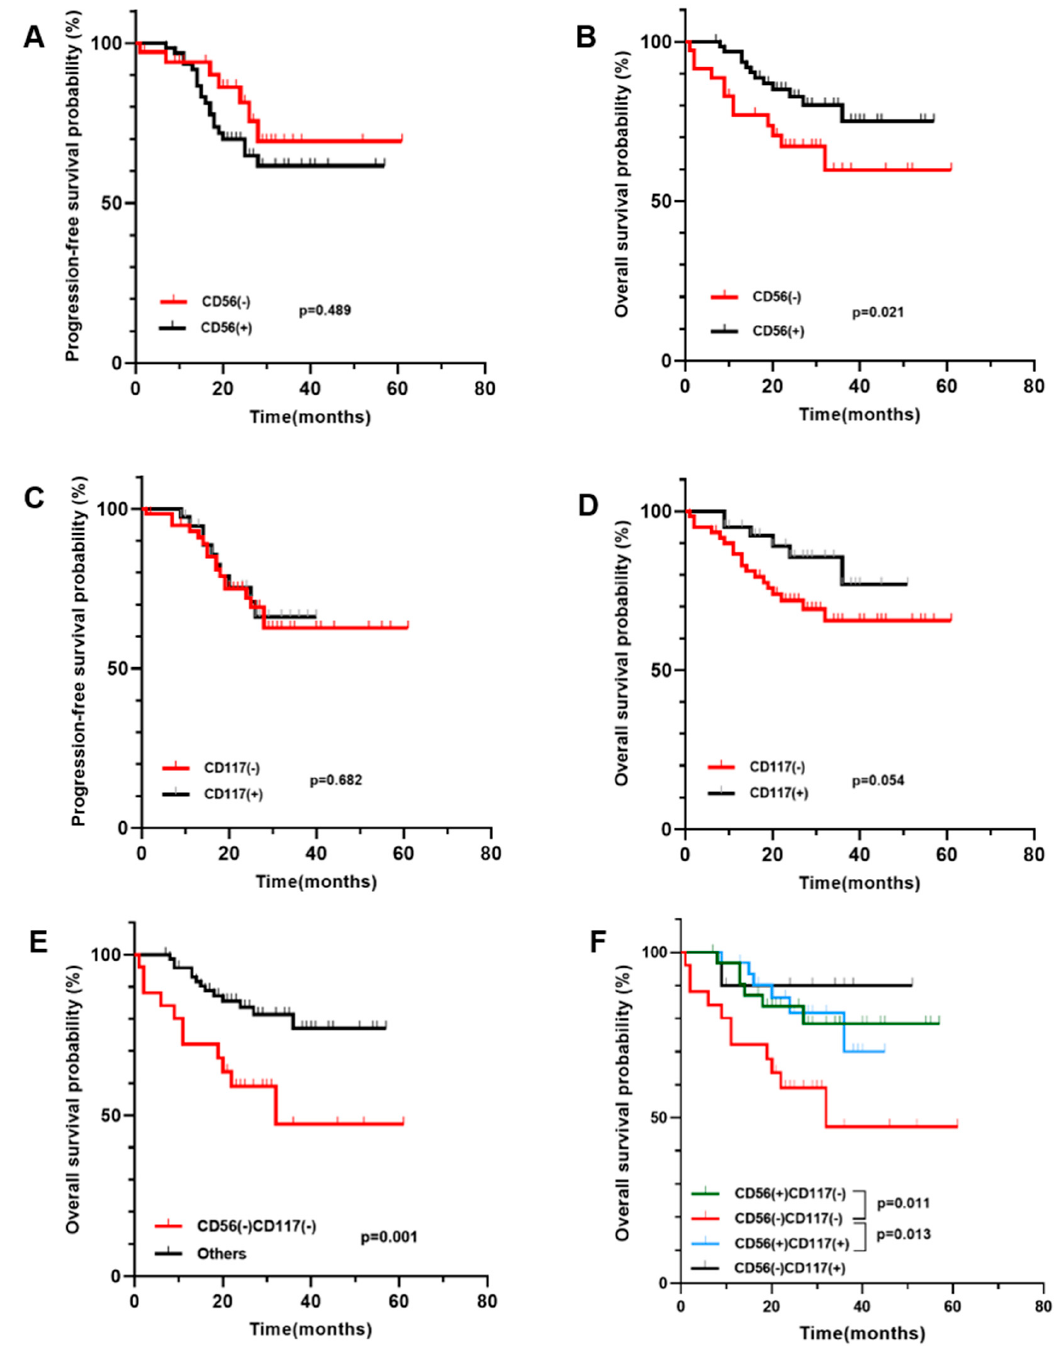
Figure 1. Kaplan-Meier curves for OS and PFS based on CD56 and CD117 expression. ( A , B ) CD56 − had a significantly shorter OS. ( C , D ) CD117 did not affect PFS or OS. ( E ) The CD56 − CD117 − group exhibited a considerably shorter OS. ( F ) CD56 − CD117 − showed a significantly shorter OS.